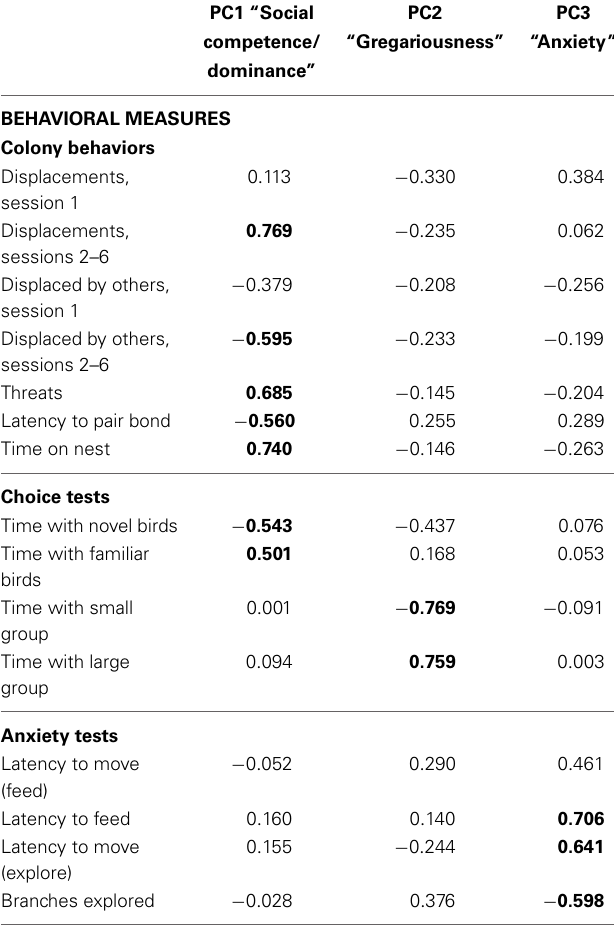
Table 1 | Principal components matrix of zebra finch behavior 1